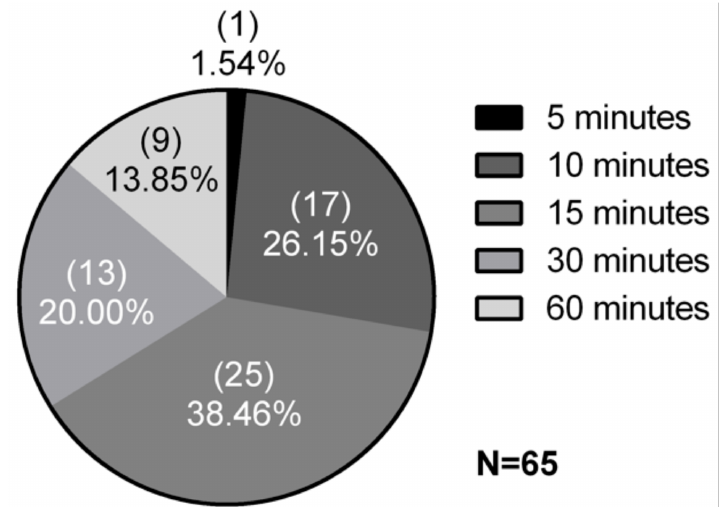
Figure 1. Screening for β -glucosidase inhibition. The 65 extracts tested belong to 63 environmental isolates. Results according to time of inhibition of the enzymatic reaction of β -glucosidase with esculin. Samples with at least 30 min of inhibition were considered positive for the presence of β -glucosidase